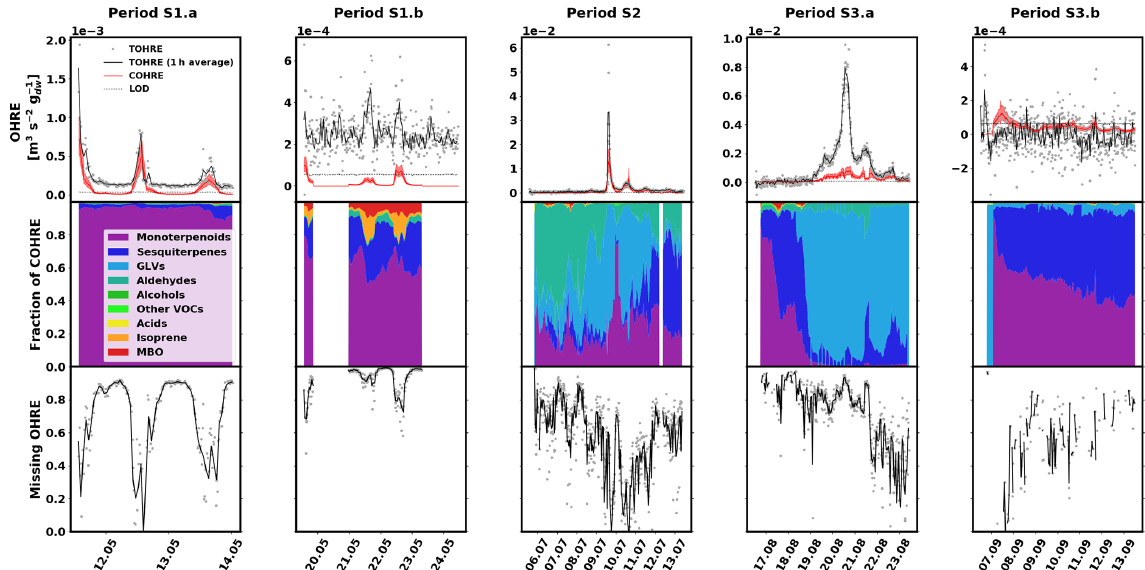
Figure 3. Measured total OH reactivity of the emissions (TOHRE), its 1h average values, and COHRE normalised to dry weight (top row) for spruce. Fraction of the various contributions of chemical species to COHRE (middle row). Missing fraction of OHRE (bottom row). The periods are denoted “S” for “spruce”, the number indicates which branch is being measured, and the letter indicates which period it is for the same